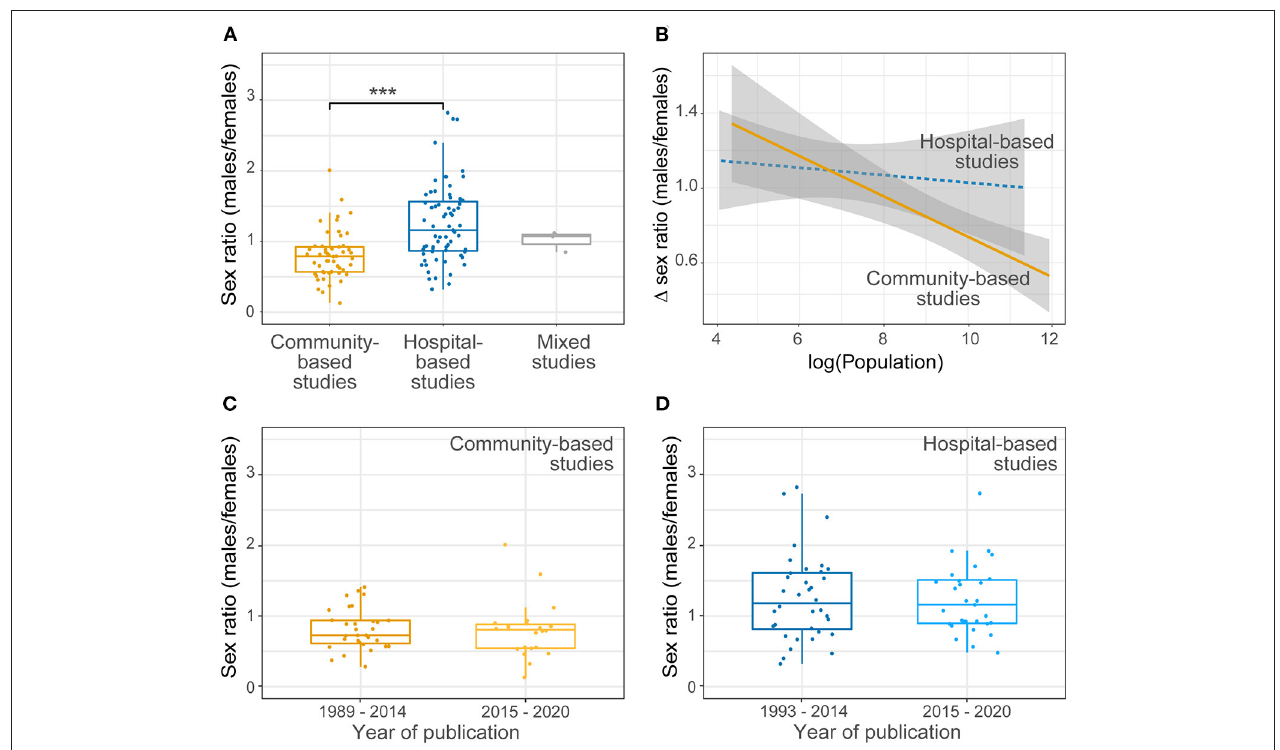
FIGURE 2 | Sex ratio of SVD studies across study setting and time. (A) Comparison of sex ratios per study type. Significant differences were found between sex ratios of community-based (CB) and hospital-based (HB) studies ( p corrected < 0.001). (B) Correlation between the sex ratio difference and the size of the recruited sample. 1 sex ratio = |sex ratio of general population – sex ratio of each study|. Given that the mean age of the participants of the included studies was 67, general population sex ratio corresponds to 70-year old population (89 males per 100 females) ( 22). There was a negative correlation between 1 sex ratio and the size of the population recruited in community studies (yellow, rho Spearman = − 0.46, p < 0.001) but not in hospital studies (blue, rho Spearman = − 0.10, p = 0.43). (C,D) Comparison of sex ratios across time. No significant differences were found between sex ratios of recent studies compared with those previously